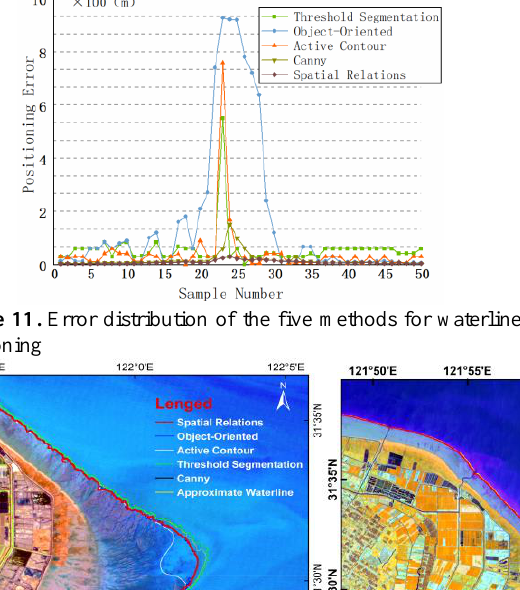
Figure12. Waterlines of remote sensing images extracted on March 3,